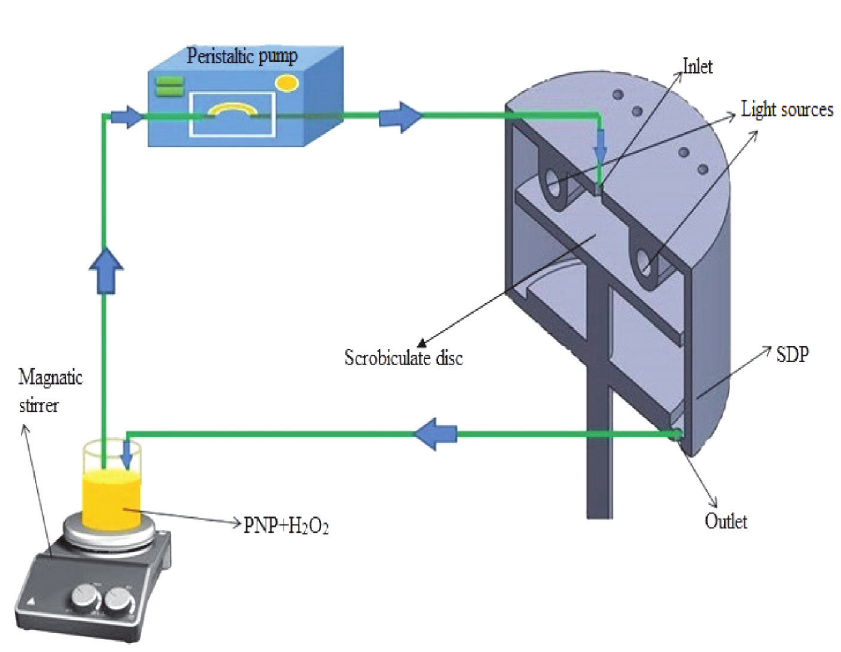
Fig. 1 – Scheme of SDP used in the UV/H